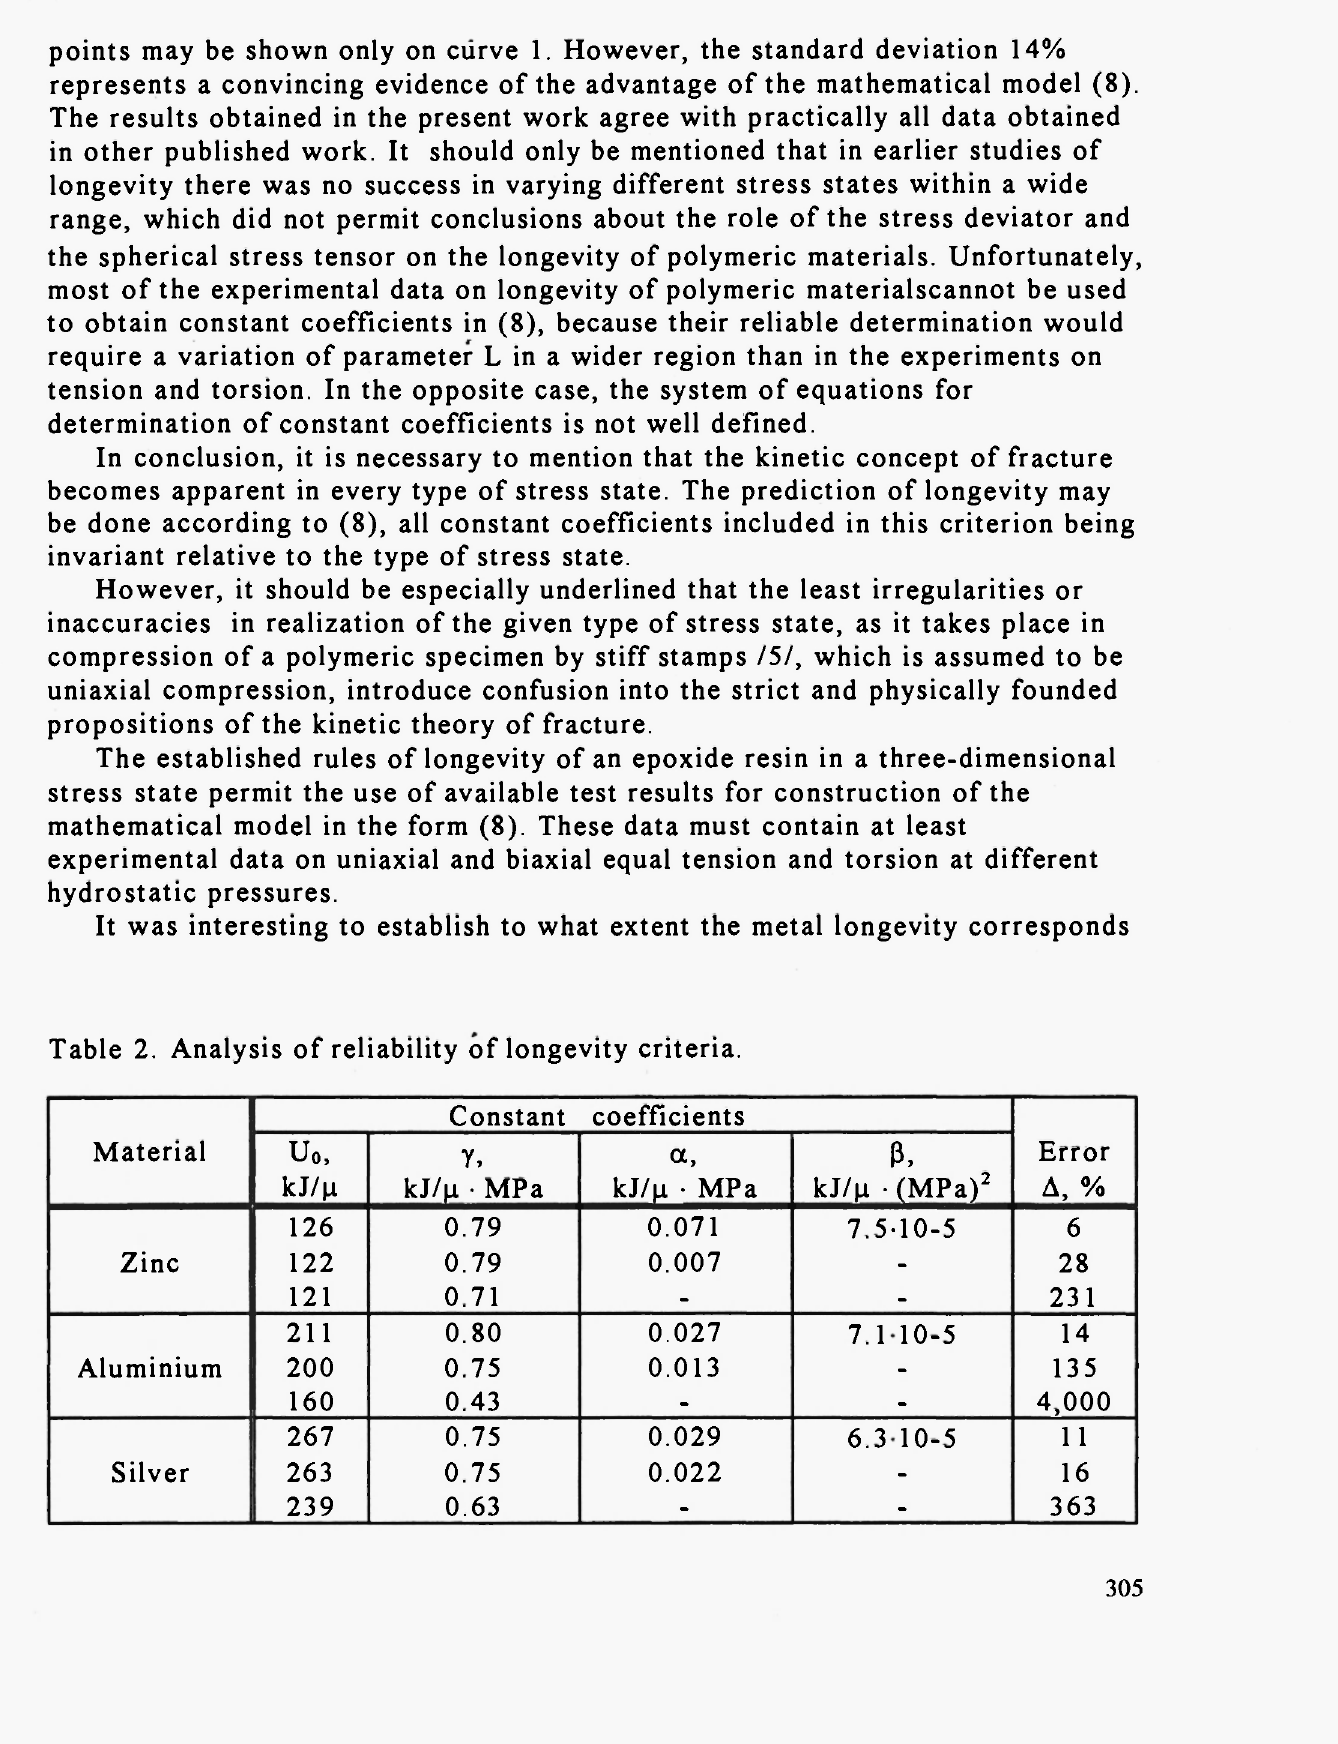
Table 2. Analysis of reliability of longevity